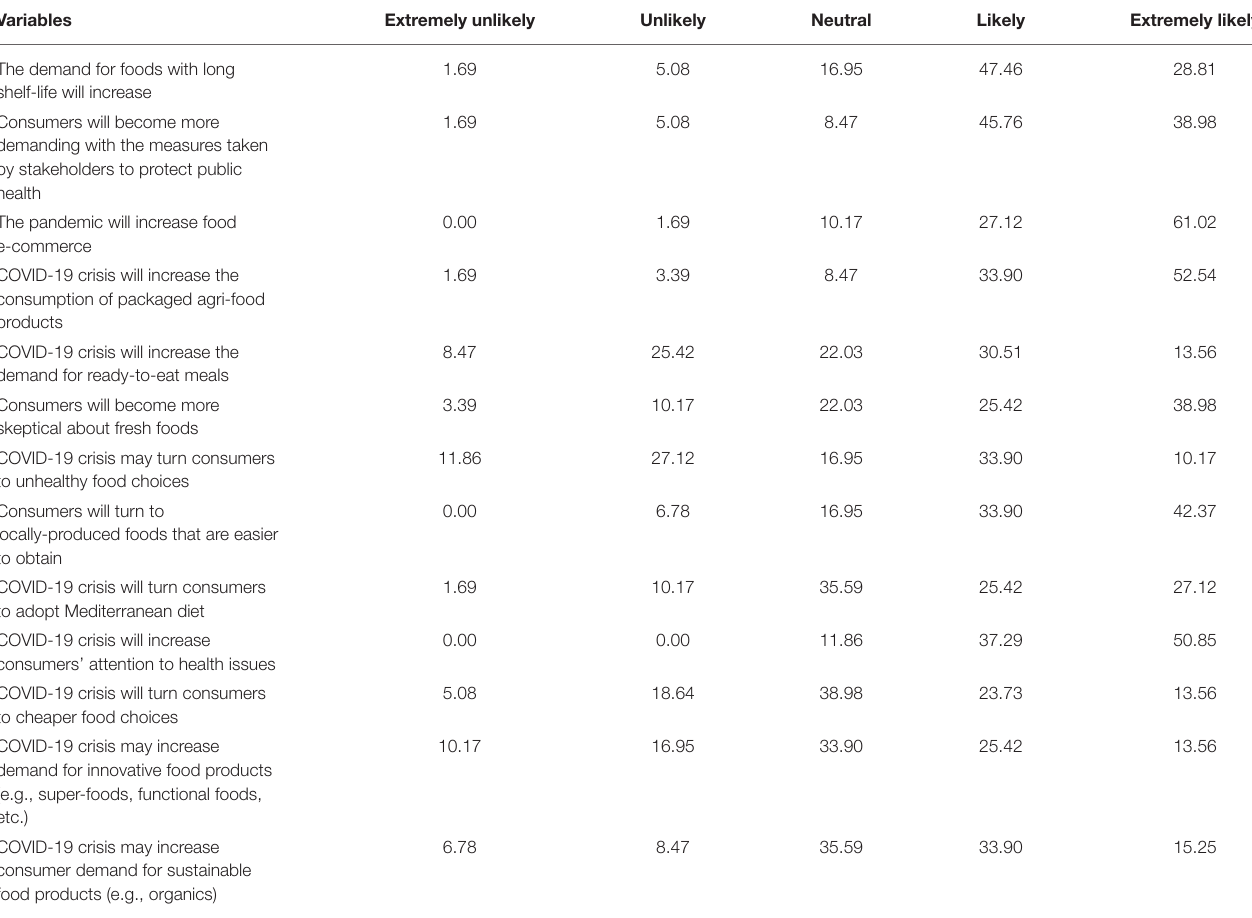
TABLE 8 | Experts’ perceptions toward COVID-19 impact on consumers’ food habits and preferences (%). Variables Extremely unlikely Unlikely Neutral Likely Extremely